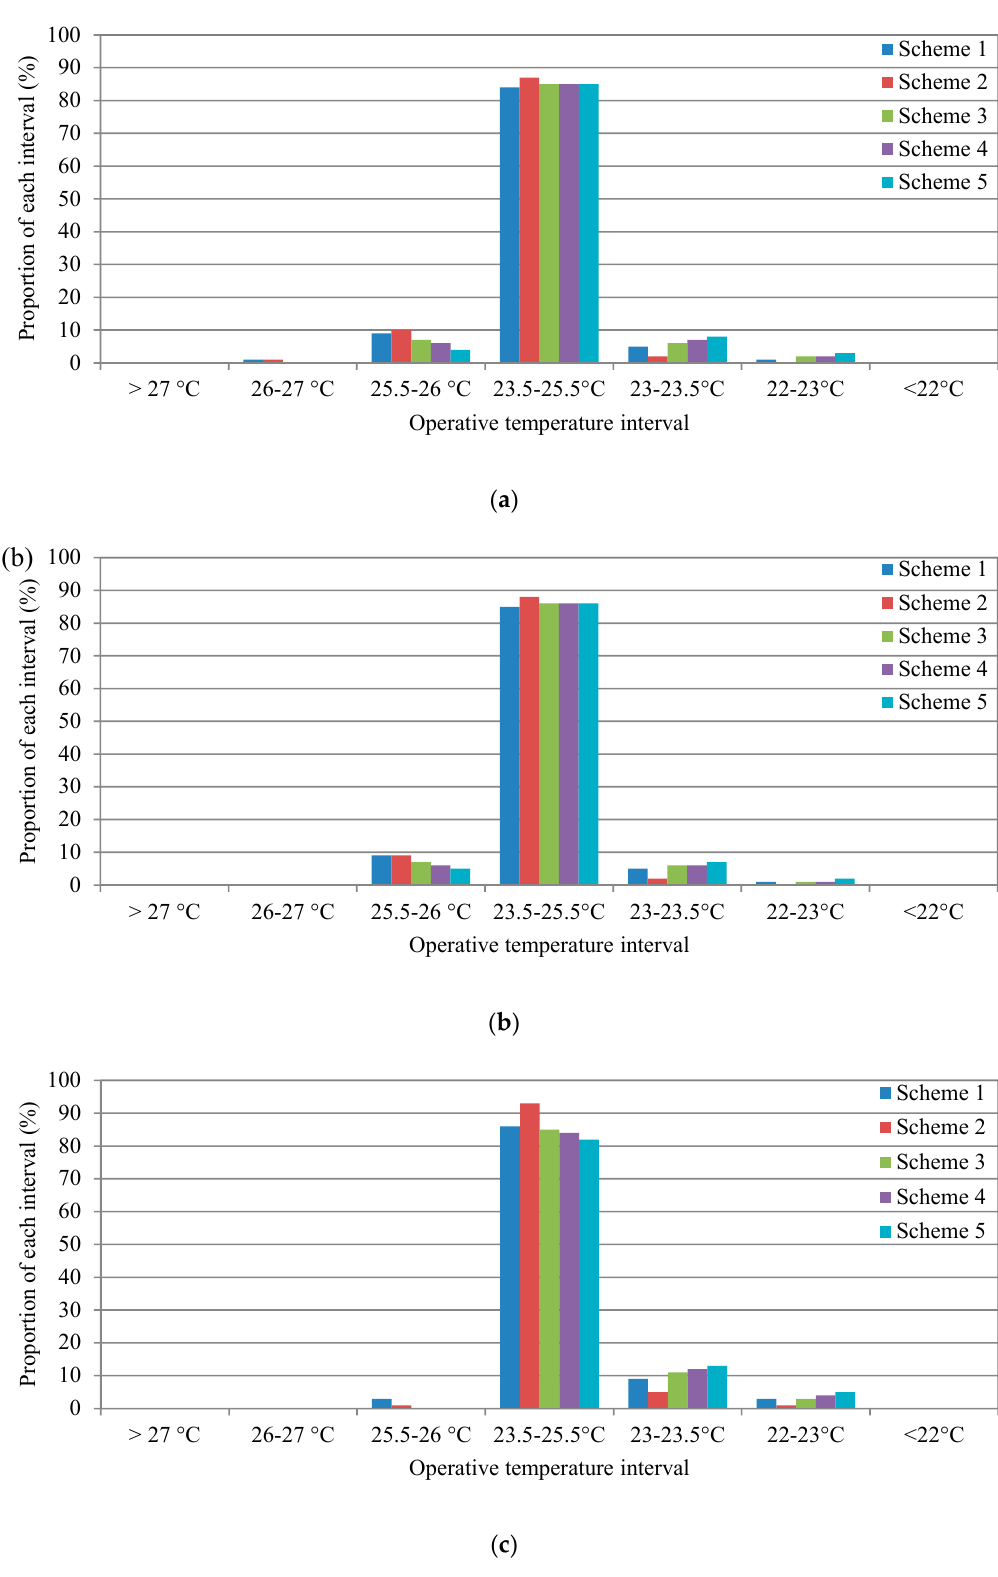
Figure 14. Proportions of time that different operative temperature intervals occur throughout the entire period of cooling under different distributions of time for cooling. ( a ) Top floor room; ( b ) second floor room; and ( c ) ground floor room.